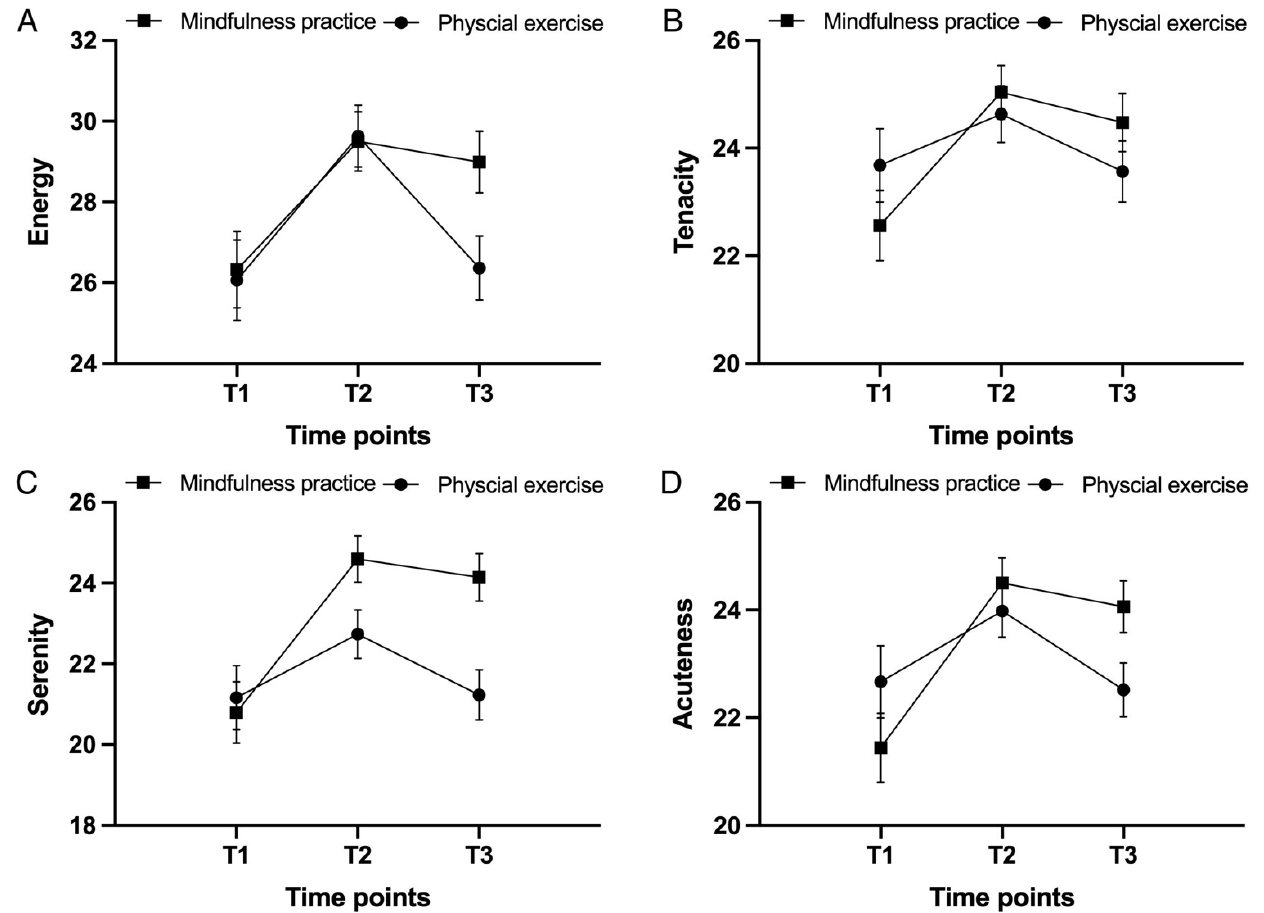
Figure 2. Levels of factors of vitality, i.e., ( A ) energy, ( B ) tenacity, ( C ) serenity, and ( D ) acuteness, for the mindfulness practice group and the physical exercise group at three time points.